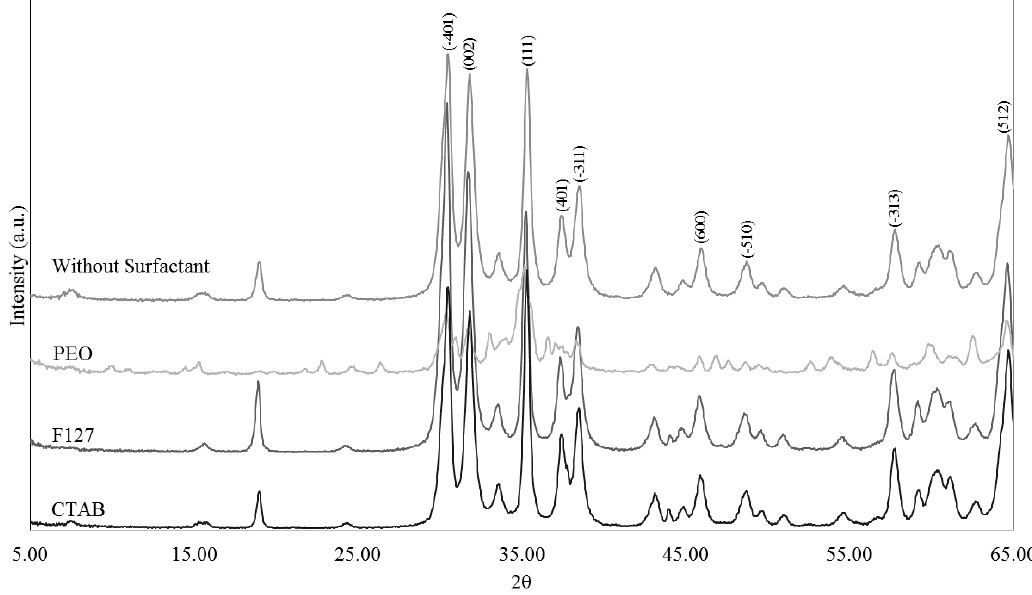
Figure 3. XRD patterns of different gallium oxide nanostructures showing the presence of the β -phase.